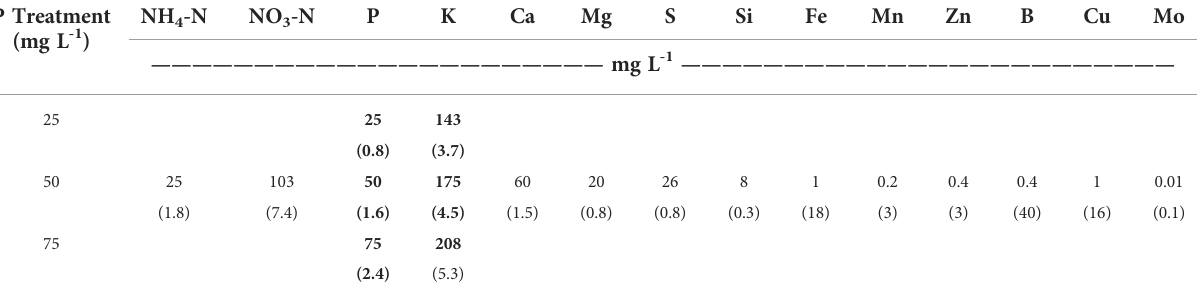
TABLE 1 The composition of the nutrient solution for the three P treatments. P Treatment (mg L -1